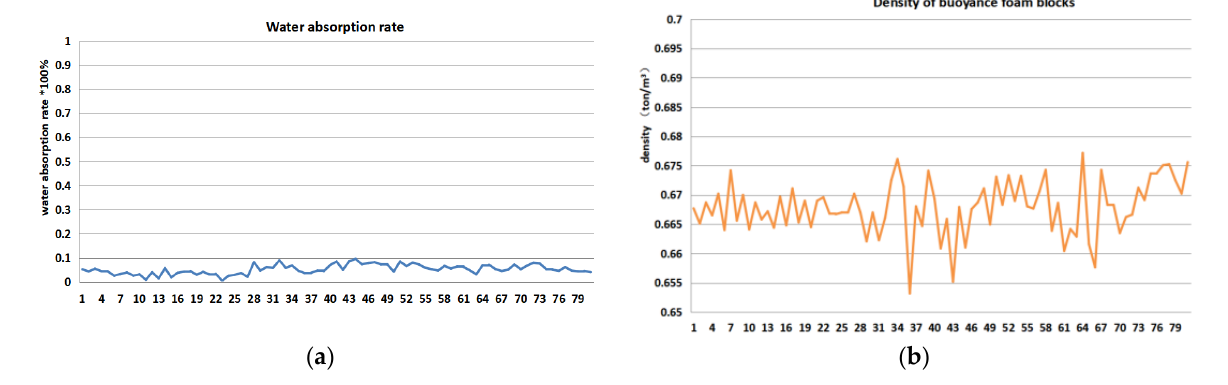
Figure 7. ( a ) Water absorption rate; ( b ) density of buoyancy foam blocks.